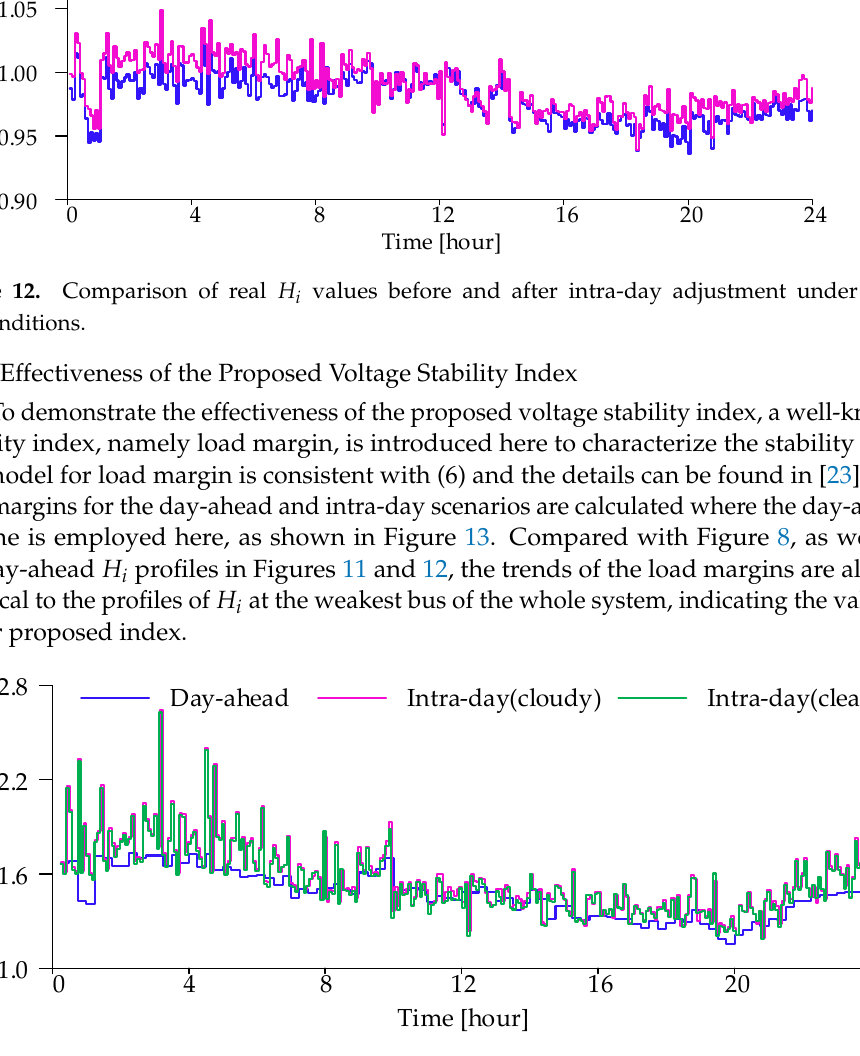
Table 1. Computational Time.